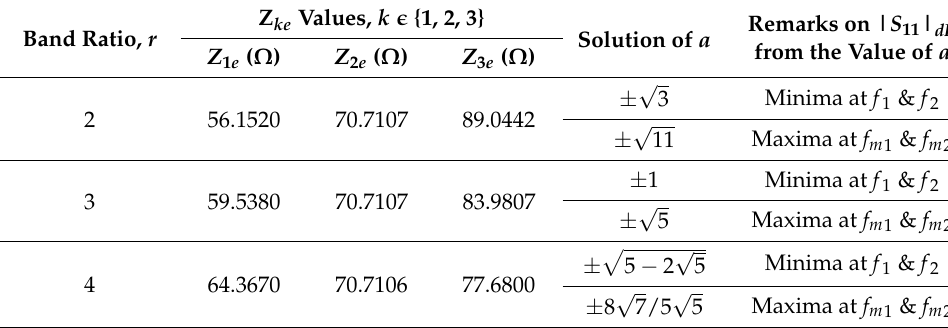
Table 1. Calculated real values of a from (63). Band ratio, r